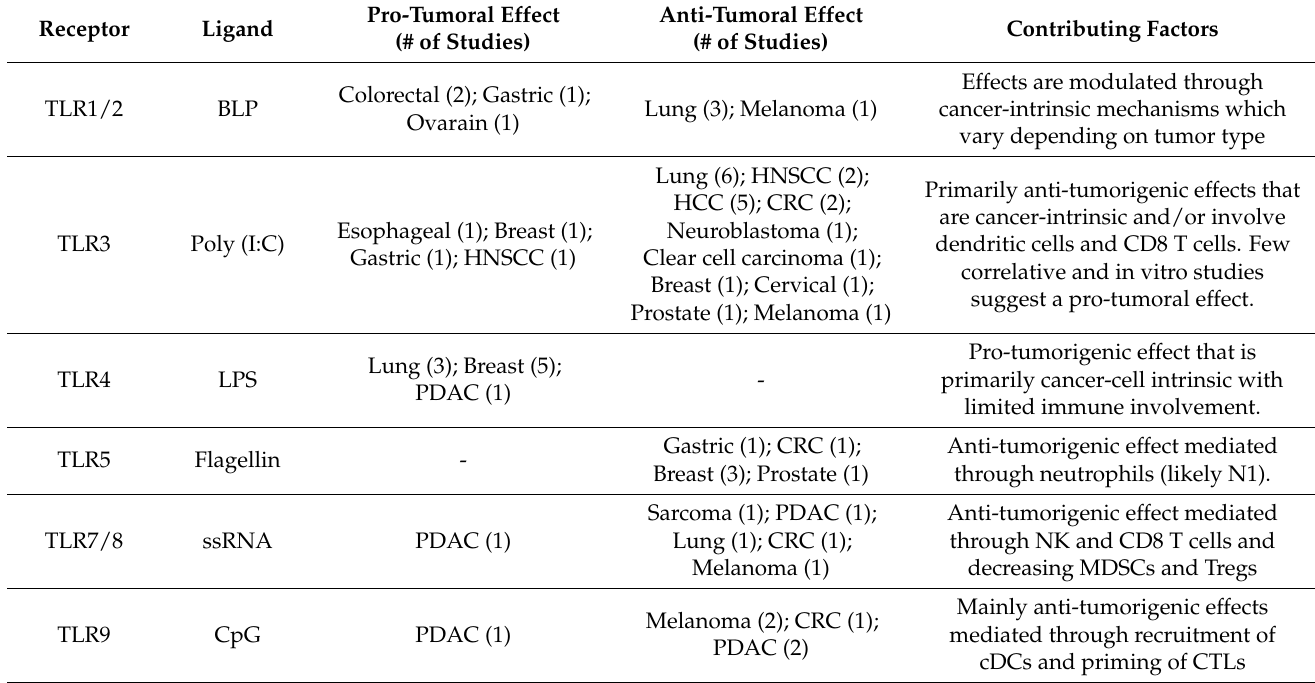
Table 1. Summary of pro and anti-tumoral effects of TLR ligation in cancer. The number of studies for each cancer site is provided in